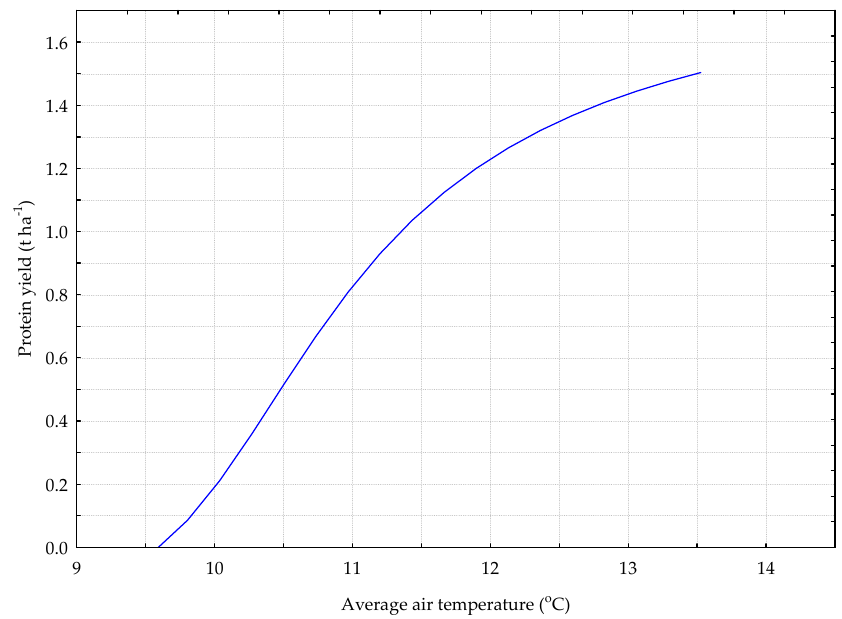
Figure 6. The P_G model. The response chart for variables T_AV (rank 1) and P_Y.